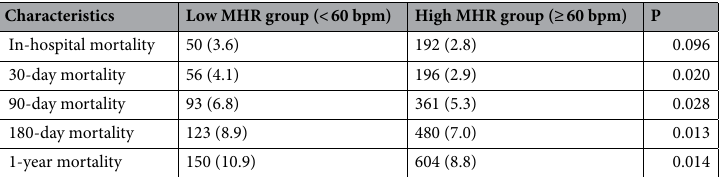
Table 1. Characteristics of participants categorized by MHR. Participants were divided into two groups, a low MHR group (MHR < 60 bpm) and a high MHR group (MHR ≥ 60 bpm). For each variable, mean ± standard deviation, median (interquartile range), or number (percent) was reported (as appropriate). BMI body mass index, SBP systolic blood pressure, DBP diastolic blood pressure, WBC white blood cell, BUN blood urea nitrogen, COPD chronic obstructive pulmonary disease, CKD chronic kidney disease, CRRT continuous renal replacement therapy, GCS glasgow coma score, SOFA sequential organ failure assessment, SIRS systemic inflammatory response syndrome, SAPS simplified acute physiological state score, LODS logistic organ dysfunction system, OASIS oxford acute severity of illness score, CABG coronary artery bypass grafting, ACEI angiotensin-converting enzyme inhibitors, PPI proton pump inhibitors.